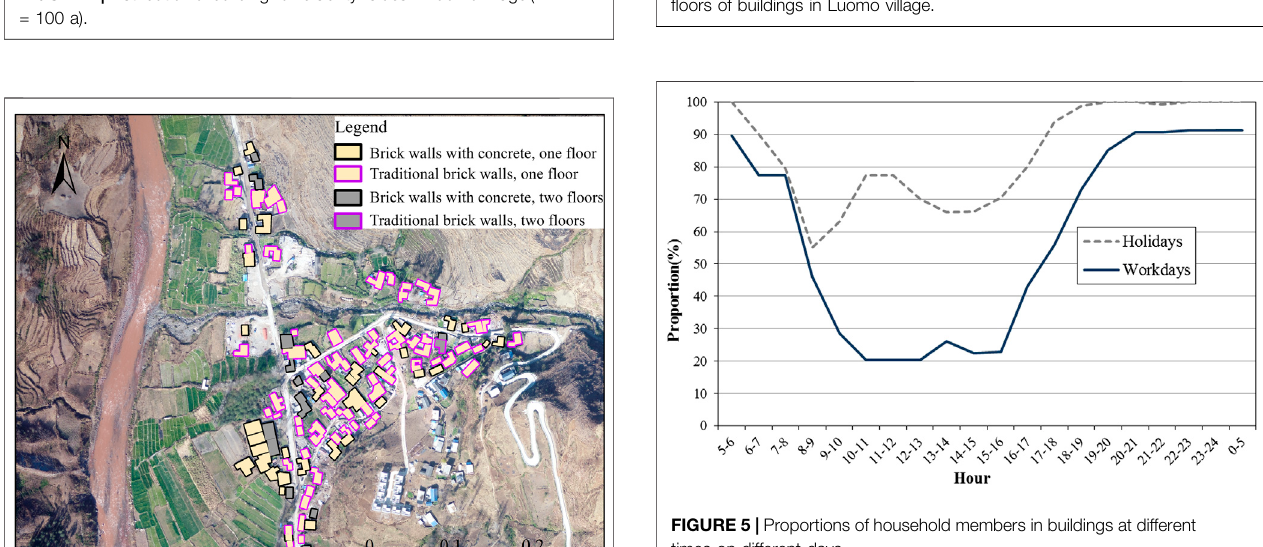
FIGURE 4 | Distributions of construction structures and the number of fl oors of buildings in Luomo village.